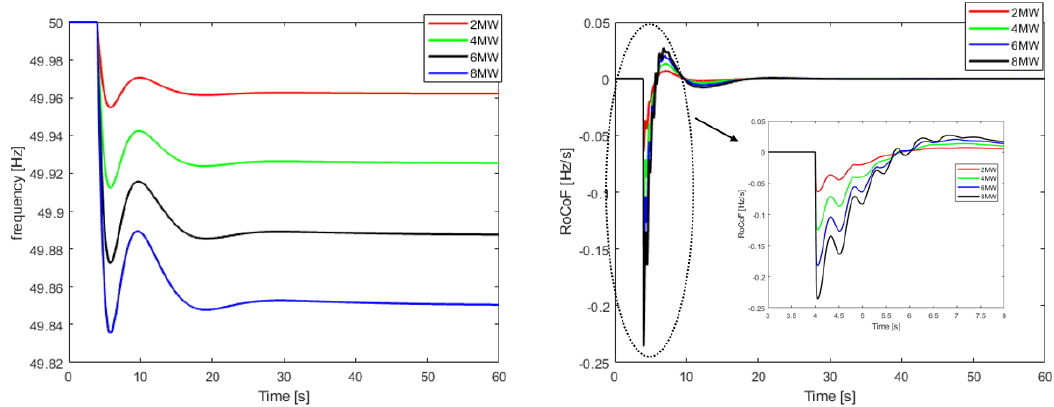
Figure 8. Load step-change frequency response and RoCoF for the worst case of the reference scenario.